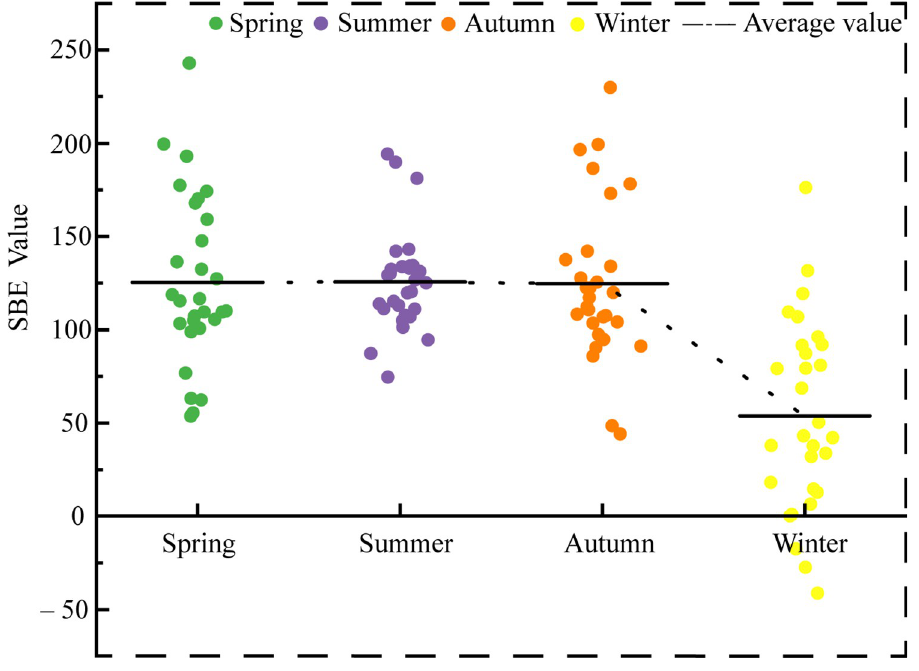
Fig 4. Variation trend of SBE value in different seasons of Jiaozi Mountain